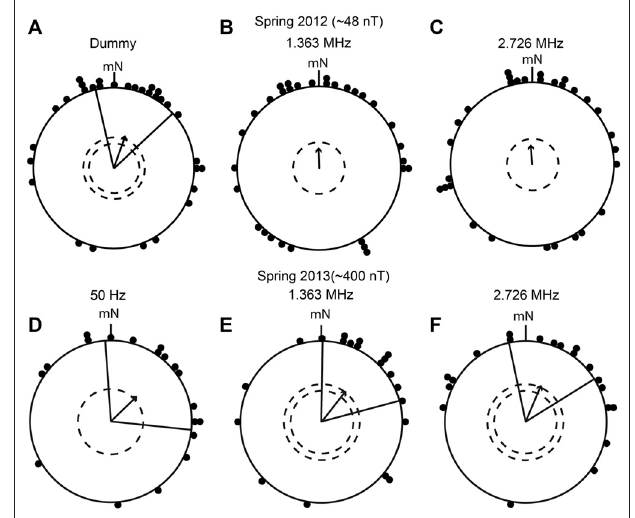
FIGURE 5 | European robins can orient in their appropriate migratory directions when they are exposed to narrow-band time-dependent magnetic fields. (A–F) : The results of orientation cage experiments on European robins. (A) Dummy condition in which the birds were not exposed to time-dependent magnetic fields (spring 2012, mean direction 17 ◦ ± 30 ◦ (95% confidence interval), r = 0.43, p < 0.01, N = 31). (B) Birds exposed to 1.363 MHz with a peak intensity of 48 nT (spring 2012, mean direction 358 ◦ , r = 0.25, p = 0.138, N = 31). (C) Birds exposed to 2.726 MHz with a peak intensity of 48 nT (spring 2012, mean direction 356 ◦ , r = 0.24, p = 0.179, N = 30). (D) Birds exposed to 50 Hz with a peak intensity of ∼ 400 nT (spring 2013, 46 ◦ ± 50 ◦ , r = 0.45, p < 0.05, N = 19). (E) Birds exposed to 1.363 MHz with a peak intensity of ∼ 400 nT (spring 2013, 38 ◦ ± 37 ◦ , r = 0.48, p < 0.01, N = 20). (F) Birds exposed to 2.726 MHz with a peak intensity of ∼ 400 nT (spring 2013, 23 ◦ ± 35 ◦ , r = 0.49, p < 0.01, N = 20). Each dot represents the mean heading of an individual bird, the arrows indicate the group mean vector, the radial lines flanking the group mean vector indicate the 95% confidence interval for the group mean direction and the dashed circles represent the significance levels ( p < 0.05 and p < 0.01) according to the Rayleigh test. mN, magnetic